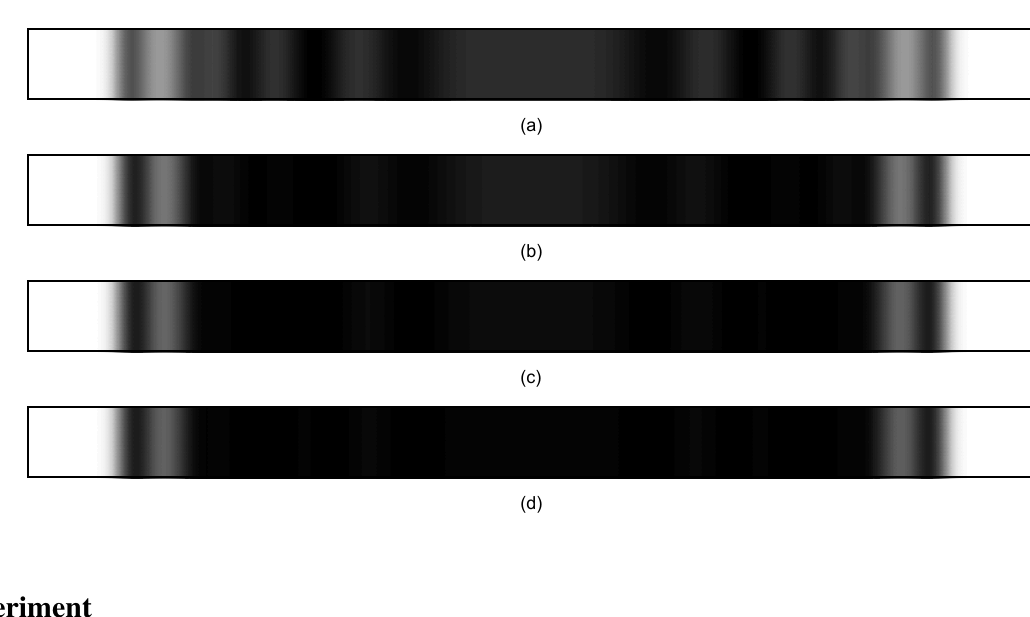
Figure 10. The formation of interference fringes for time intervals: ( a ) T1; ( b ) T2; ( c ) T3; ( d )